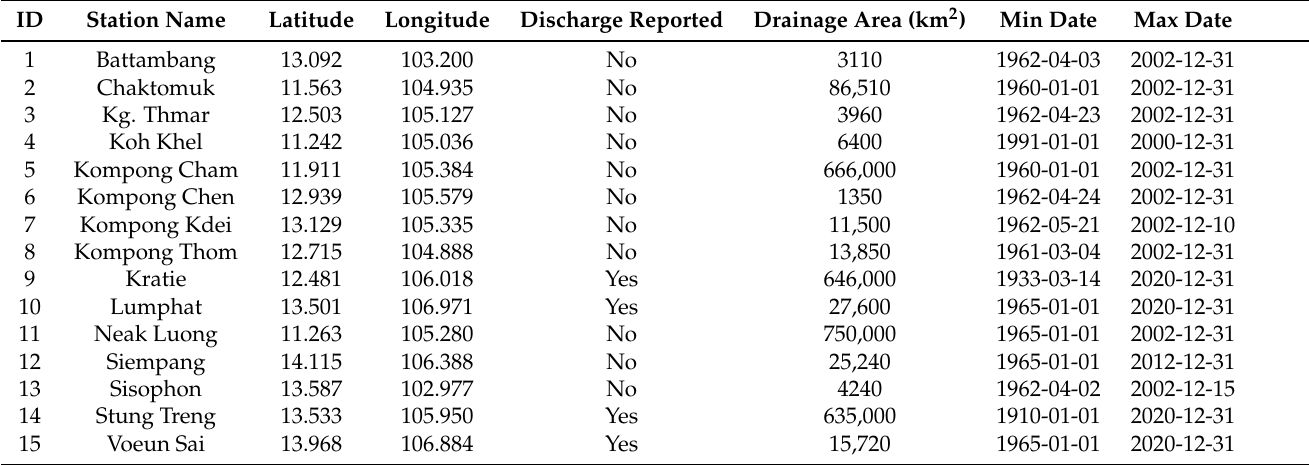
Table 1. List of stations in Cambodia and their location used in the study. The ‘ID’ column maps to the stations shown in Figure 1. The ‘discharge reported’ column indicates whether the discharge for that station was reported regularly when the study was started. The ‘Min Date’ and ‘Max Date’ represent the earliest and latest stage-discharge pair available for the station.